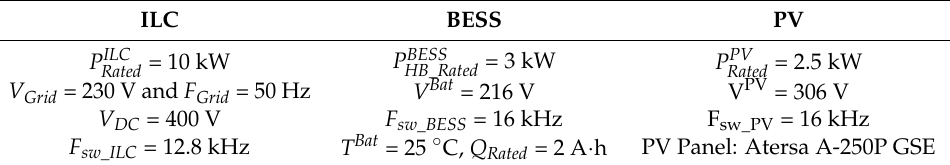
Table 7. Specifications of the power converters operating in the DC microgrid.